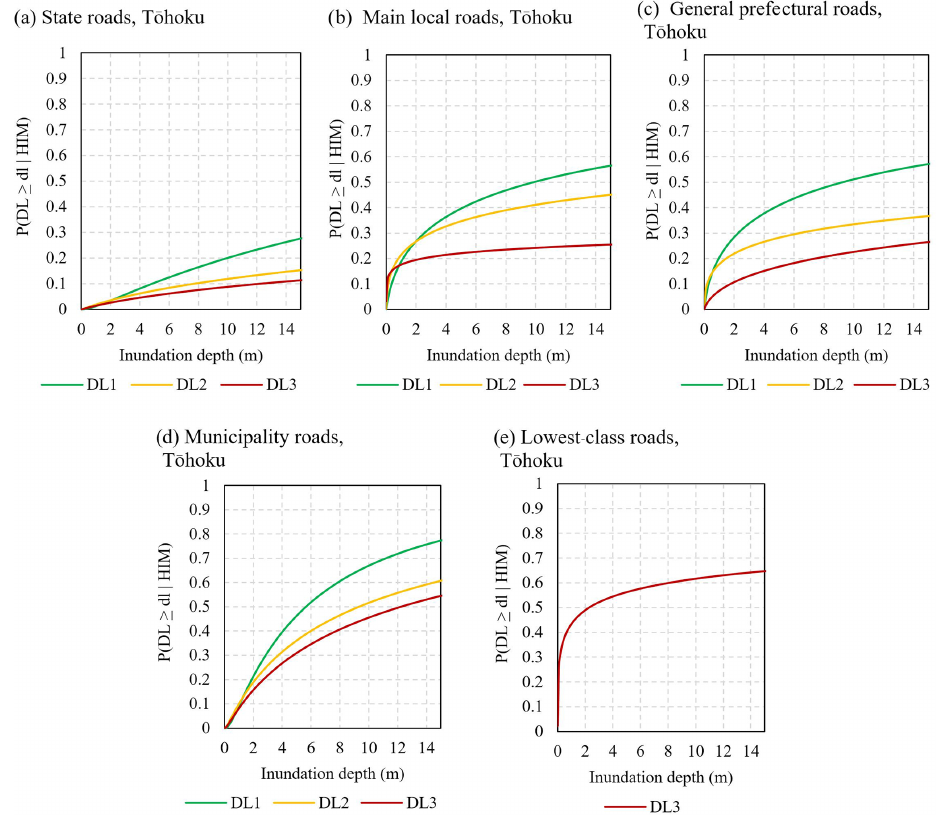
Figure 18. Fragility functions for inundated state roads (a) , main local roads (b) , general prefectural roads (c) , municipality roads (d) and lowest-class roads (e) (as an indicator of construction type and materials) in Miyagi and Iwate prefectures following the 2011 T¯ohoku earthquake and tsunami, Japan.